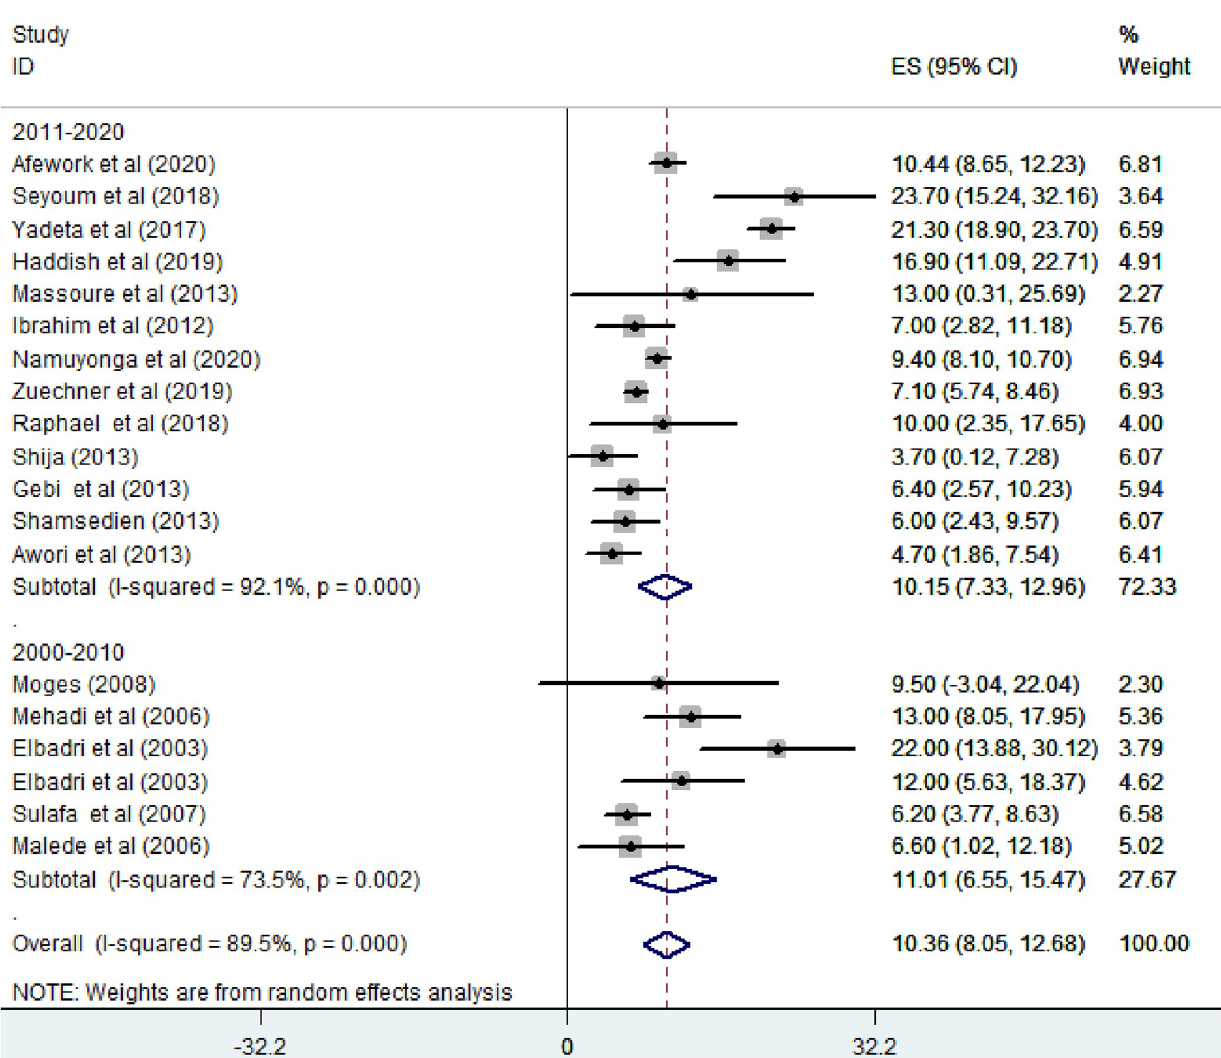
Fig 10. Forest plot showing the subgroup analysis of the prevalence of atrial septal defect among congenital heart defect patients by year of publication in East Africa, from January 2000-October 2020.